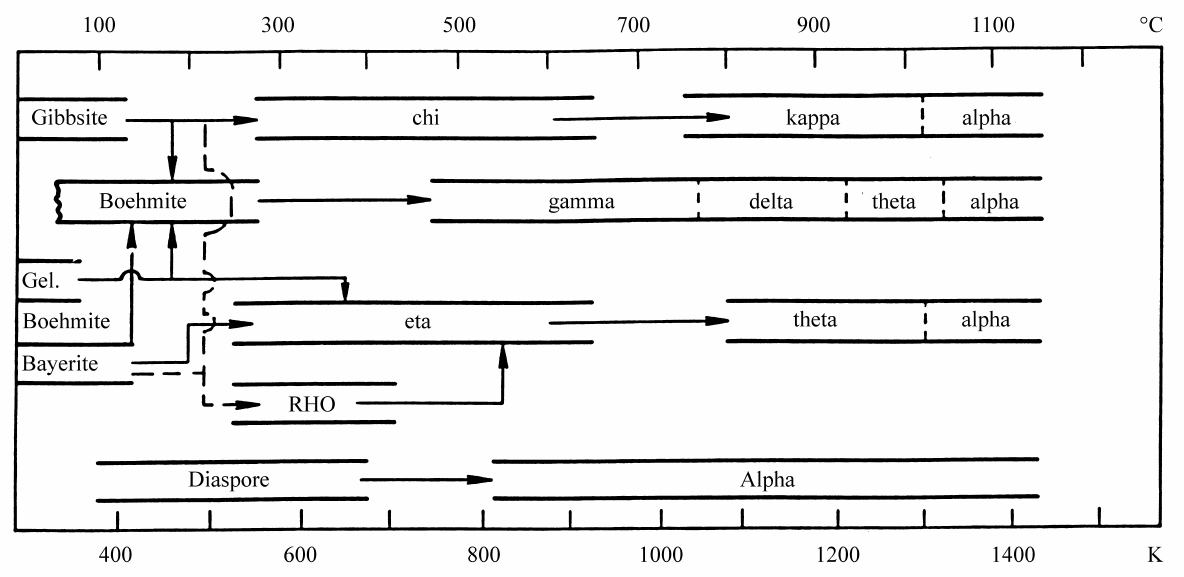
Figure 1. Thermal transformation sequence of the aluminum hydroxides (adapted from Ref.